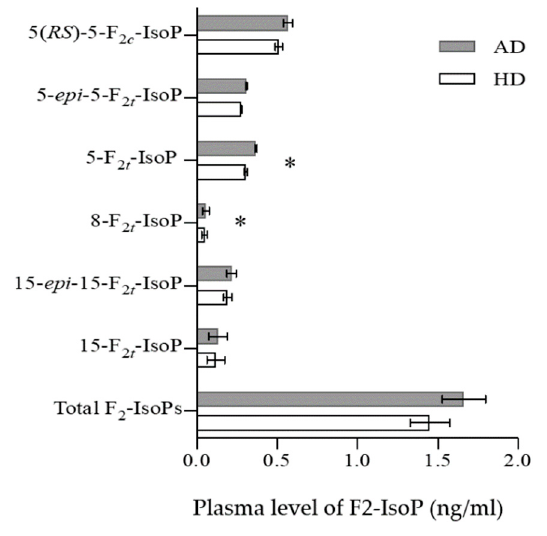
Figure 1. Plasma levels of F 2 -IsoProstane (F 2 -IsoPs) (ng/mL) in response to adequate-dairy (AD) and high-dairy diet (HD). Data are means ± SD (n = 27). * p < 0.05 significant. GLMM analysis that took into account BMI and sex showed that after HD intake the total levels of F 2 -IsoP ( p = 0.03, − 11%), 5-F 2t -IsoP ( p = 0.002, − 16%) and 8-F 2t -IsoP ( p = 0.004, − 15%) were lower in comparison to AD (Table 3; Figure 2). Table 3. Coefficient estimates from GLMM analyses for F 2 -Isoprostane isomers following adequate dairy product intake (AD) and high dairy product intake (HD) in subjects with hyperinsulinemia. Isoprostanes (IsoPs) f -Statistic (ng/mL)